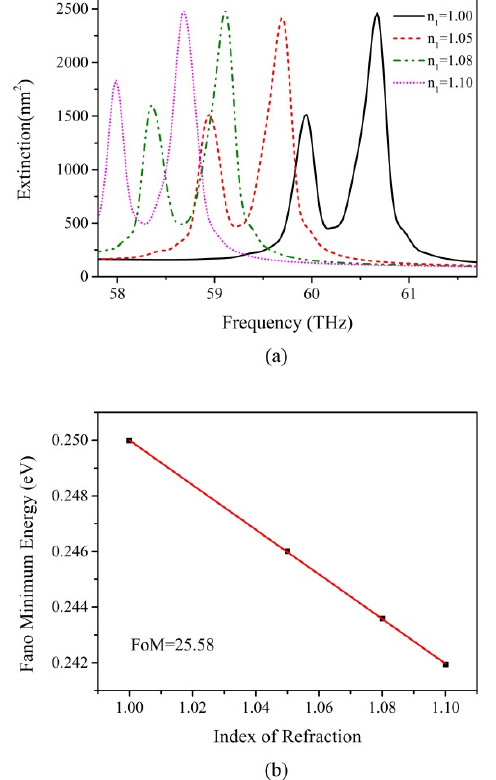
Figure 7. The refractive sensing effect in graphene hexamer. ( a ) The Fano ‐ like resonance has high sensitivity to the variation of environment. It red shifts dramatically with changing the index of refraction n 1 ; ( b ) Linear plot of the Fano minimum energy shifts vs refractive index of the surrounding environment. The calculated figure of merit is 25.58.